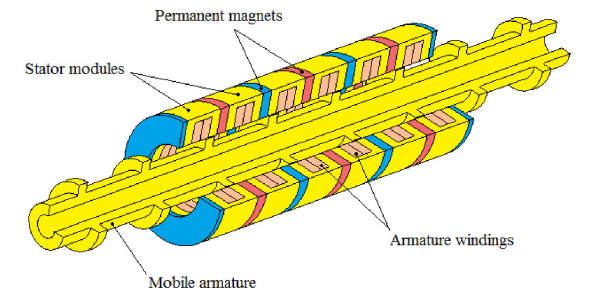
Figure 4. Typical structure of tubular LIM with permanent magnets (Lo et al.